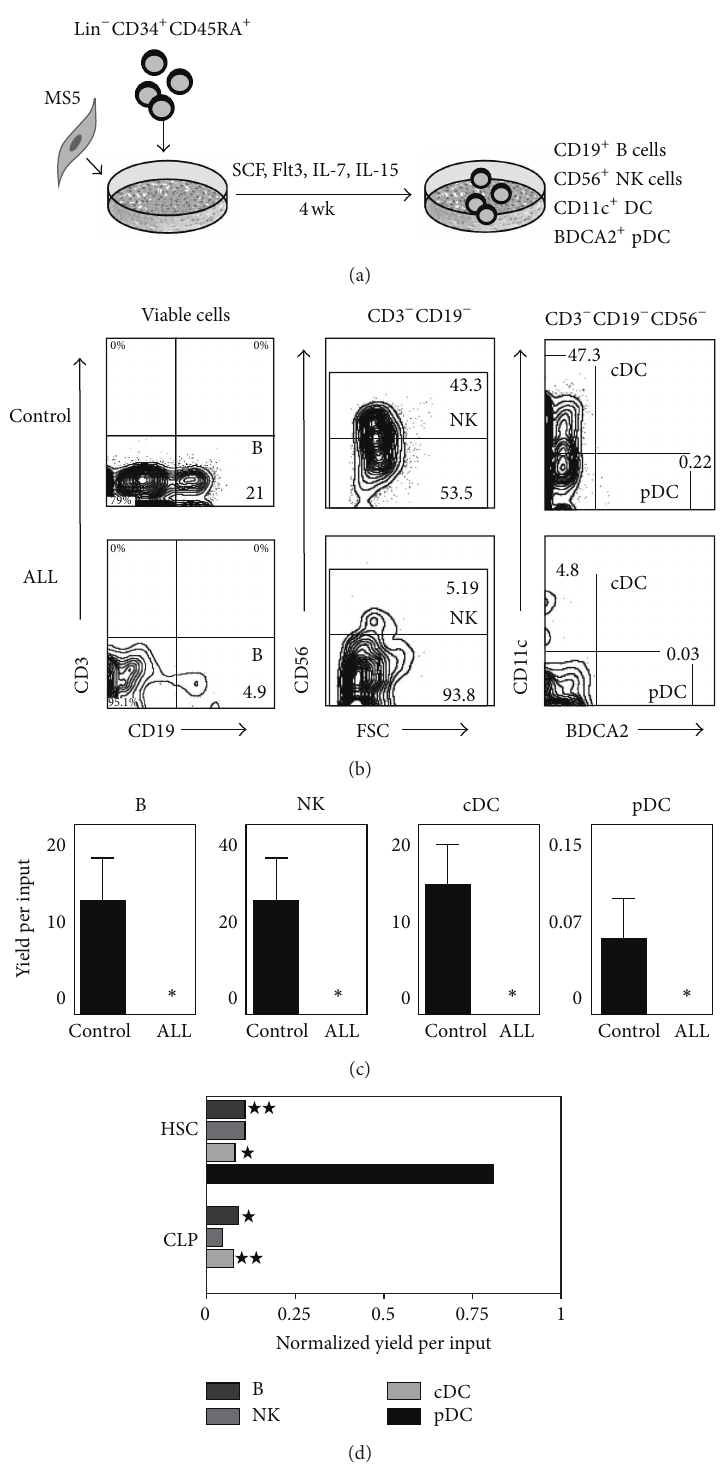
Figure 2: Defective lymphoid-differentiation potential of primitive bone marrow cells in ALL. Progenitor cell fractions were isolated from controlandALLbonemarrow(BM)andplacedinlymphoidcoculturesfor4 wkonMS-5stromalcellswithSCF,FL,IL-7,andIL-15beforeflow cytometry analyses. The general culture approach is shown (a). Cell frequencies of recovered B, NK, conventional dendritic, and plasmacytoid dendritic cells from Lin − CD34 + CD45RA + differentiation cultures were further calculated, and their absolute numbers tabulated as yield per input progenitor ((b) and (c)). Highly purified HSC and CLP cells were cultured in the same conditions and the resulting yields were normalized to control values (d). HSC: hematopoietic stem cells; CLP: common lymphoid